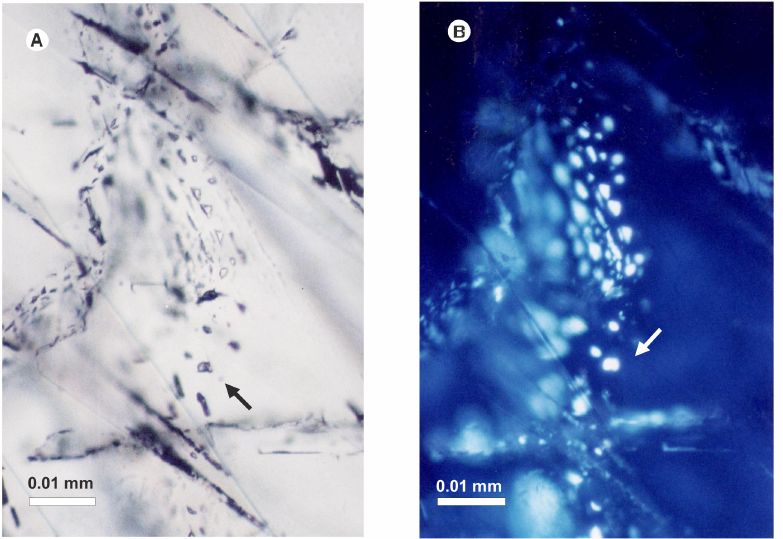
Figure 5. Secondary assemblages of bi-phase fluid inclusions in quartz in the Jabłonki settlement (JRC area). ( A ) Polarizing microscope, one polarizer, transparent light; ( B ) Polarizing microscope, UV, reflected light.